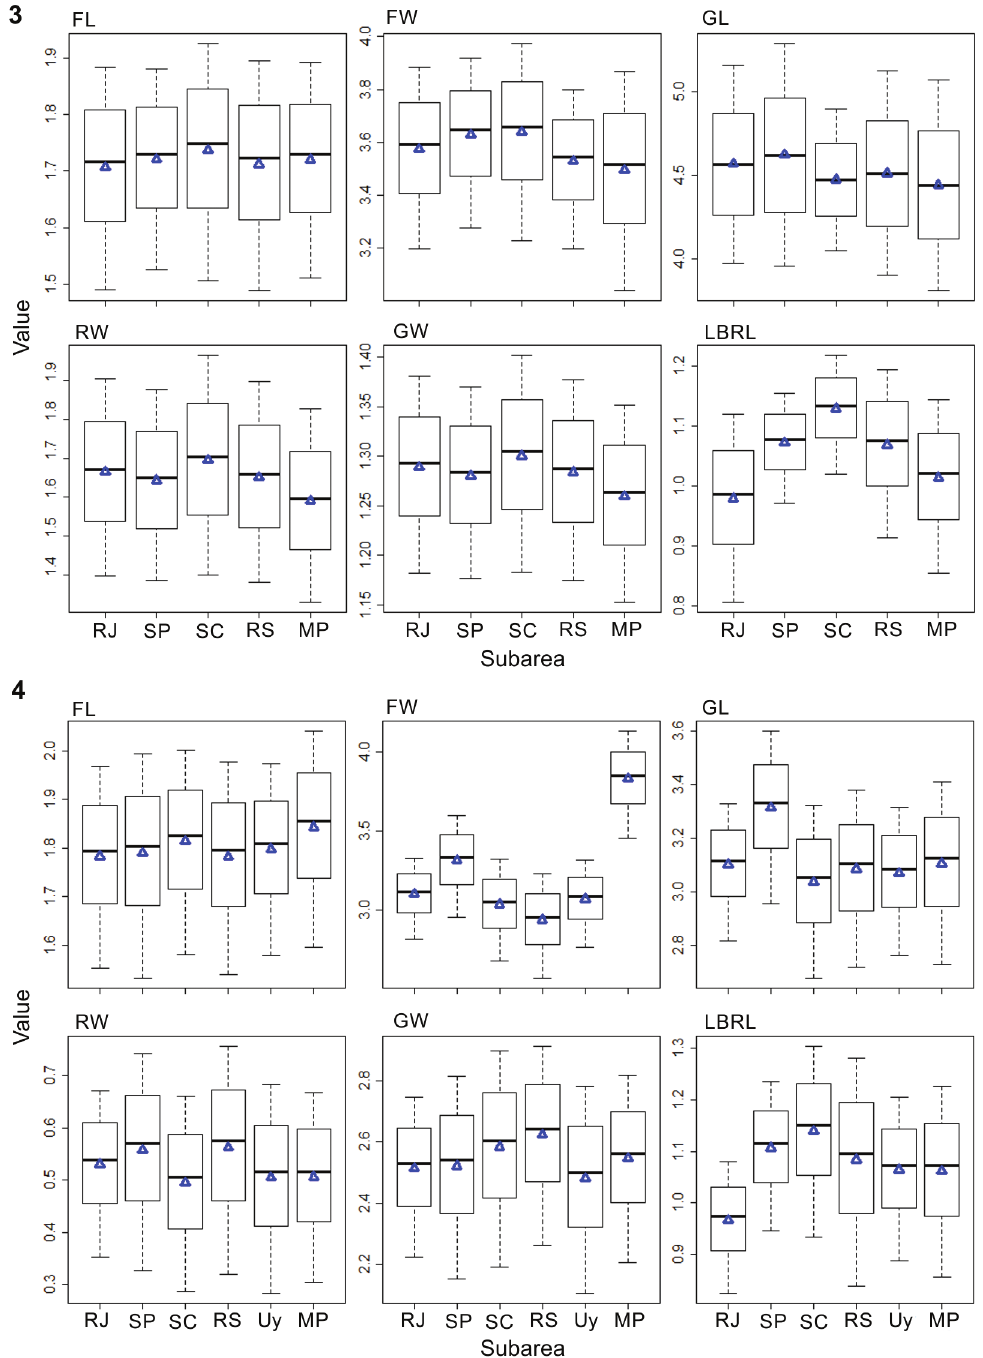
Figures 3–4. Box-Whisker plots of standardized values of attributes for the soft body parts of Doryteuthis sanpaulensis females (3) and males (4) from each region surveyed. Blue triangles represent mean values. FL: fin length, FW: fin width GL: gill length, RW: raquis width, GW: gladius width, LBRL: lower beak rostral length. RJ: Rio de Janeiro, SP: São Paulo, SC: Santa Catarina, RS: Rio Grande do Sul, Uy: Uruguay, MP: Mar del